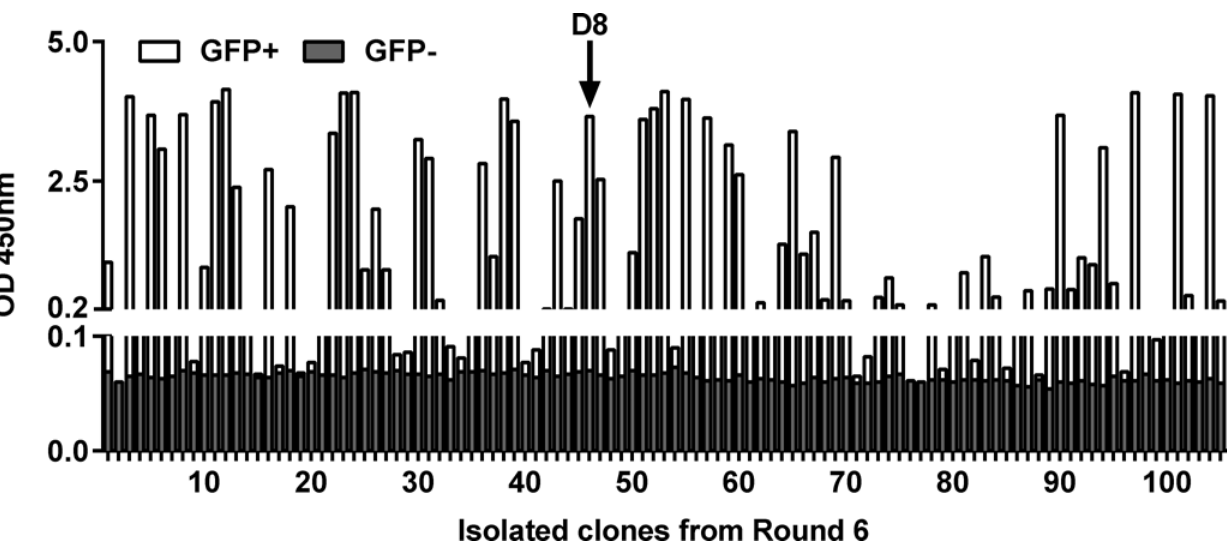
Fig 2. ELISA screen of the anti-GFP Nanofitins. Diversity from the sixth round of selection was screened by ELISA in presence (white bars) and absence of immobilized StrepTagII-GFP (superimposed grey bars). Anti-GFP Nanofitin D8 signals are indicated with an arrow.